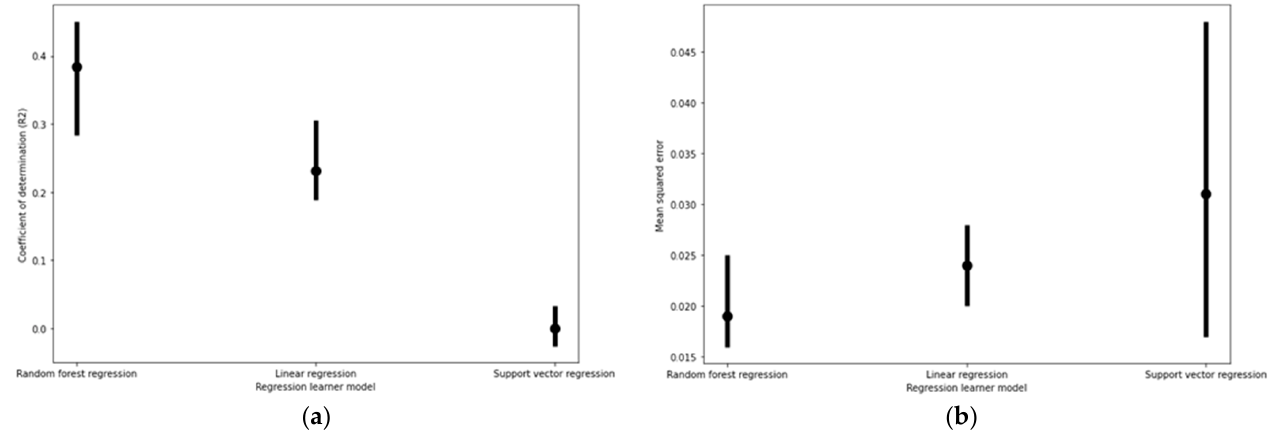
Figure 1. Cell viability regression model performance based on ( a ) coefficients of determination (R 2 ) and ( b ) mean squared error (MSE) values under fivefold cross validation. The upper and lower bounds of the error plots represent the maximum and minimum R 2 and mean square error values produced amongst the five testing and training combinations.